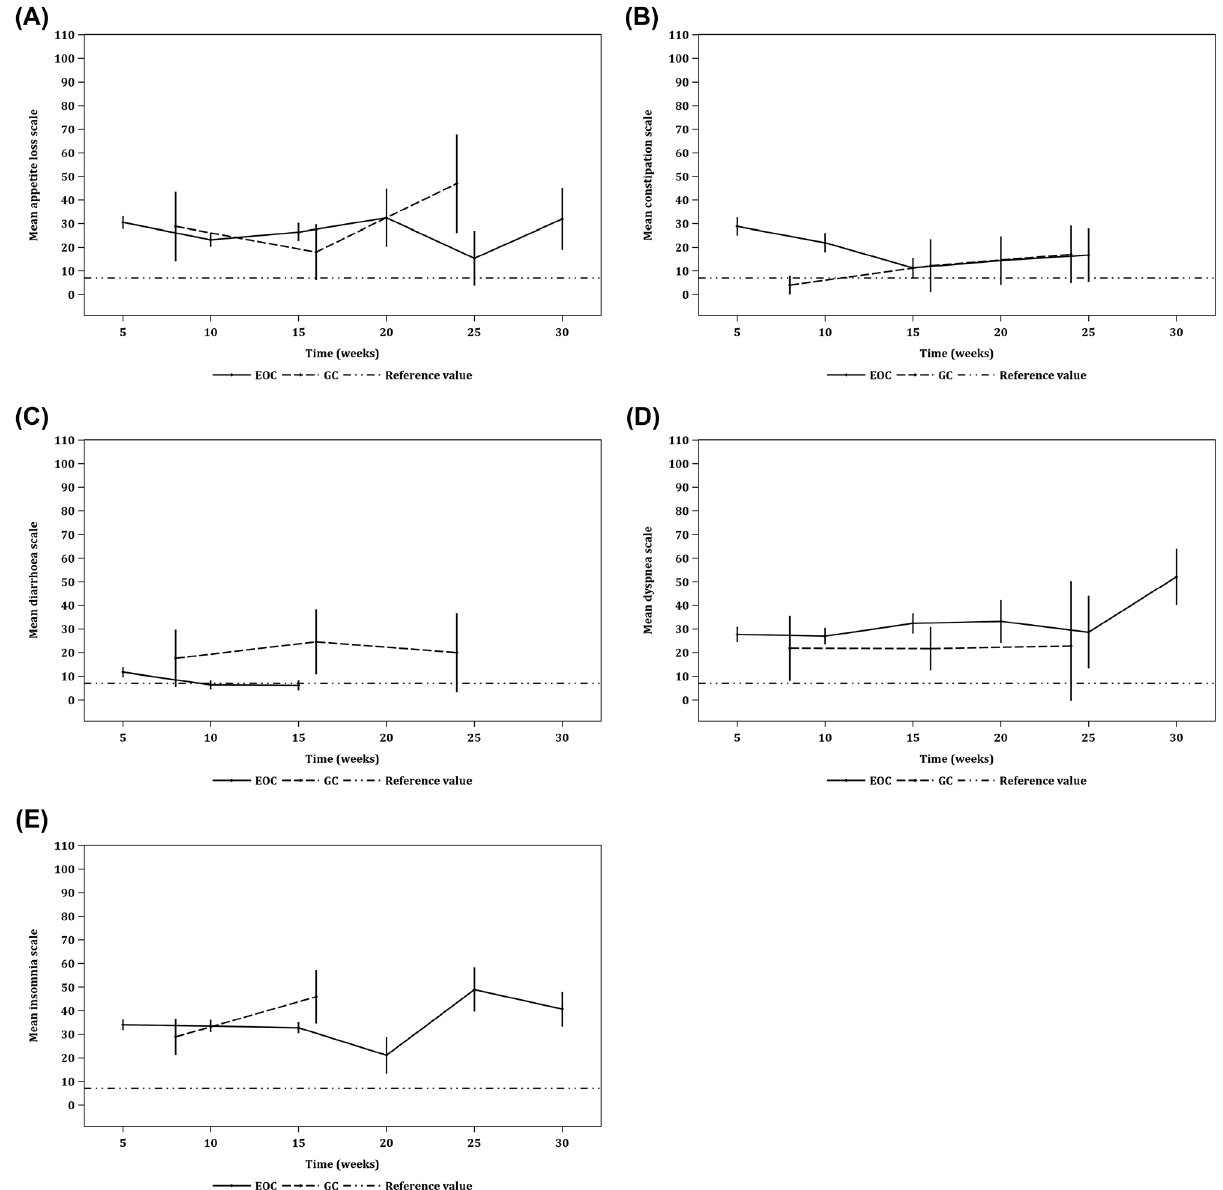
Figure 5: Line graphs depicting the single-itemed symptom scales of QoL as measured by EORTC QLQ-C30 across time. Linegraphsof (A)appetiteloss,(B)constipation, (C)diarrhea,(D)dyspnea,and(E)insomnia.Eachthree-point trendlinedepictsitsrespective single-itemedsymptomscoresbeforethe fi rst,second,andthirdcyclesofPIPAC(c)inpatientswithPMfromgastriccancer(GC);c1=31,c2=22, c3=5.Eachsix-pointtrendlinedepictsitsrespectivesingle-itemedsymptomscoresbeforethe fi rst,second,third,fourth, fi fth,andsixthcycles of PIPAC in patients with PM from epithelial ovarian cancer (EOC); c1=104, c2=70, c3=50, c4=9, c5=6, c6=4. The diarrhea scale (DI) for EOC patientsonlyhasthreedatapointsbeforethe fi rst,second,andthirdcyclesofPIPACwhereastheconstipationscale(CO)forEOCpatientsonly has fi ve data points from the fi rst, second, third, fourth, and fi fth cycles of PIPAC. Error bars represent 95% CIs. Signi fi cant deterioration was found in DI and CO within EOC. As a reference, each dashed line represents a snapshot of its respective single-itemed symptom score in 6 – 18 months after CRS/HIPEC in a cohort of patients (n=27) with PM from a mixed histological